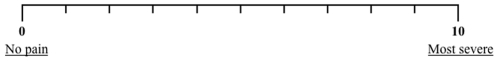
The line used for the visual analogue scoring of pain in each sequence.For each sequence the participants were asked to place a mark on the line at the point they score the pain the rabbit was experiencing by placing a mark on the line at the point they felt corresponded to the pain experienced by the rabbit. They were told that 0 represented no pain and 10 represented the most severe pain they could imagine.